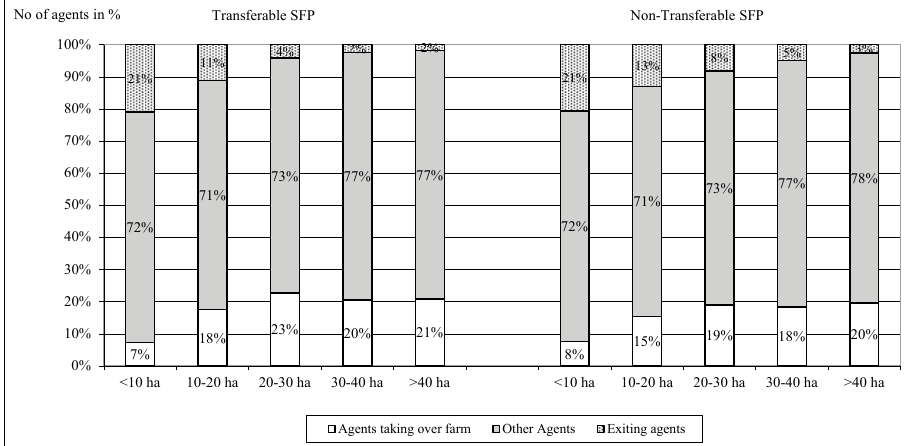
Figure 7. Percentage of exiting agents and agents taking over farm from predecessors in different farm-size categories (D1).